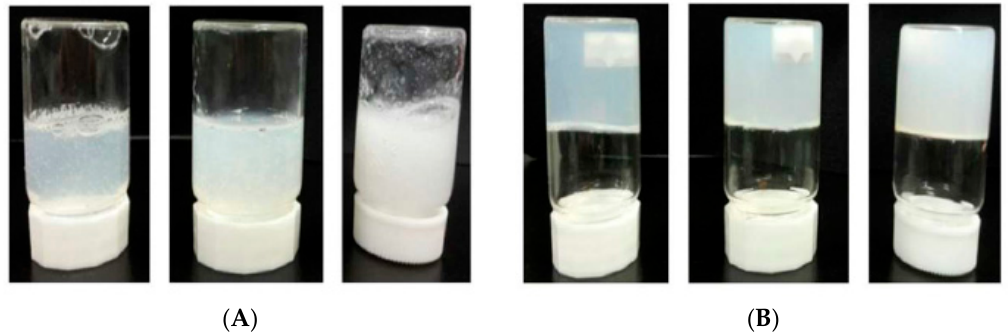
Figure 1. Photographs of the state of the N -Palmitoyl-Glycine-Histidine (Pal-GH) gel formulation in the bottles. The bottles were placed in an inverse position immediately ( A ) and 5 min after ( B ) shaking. The Pal-GH concentrations are, from left to right in both photos, 2.5%, 5%, and 10%.